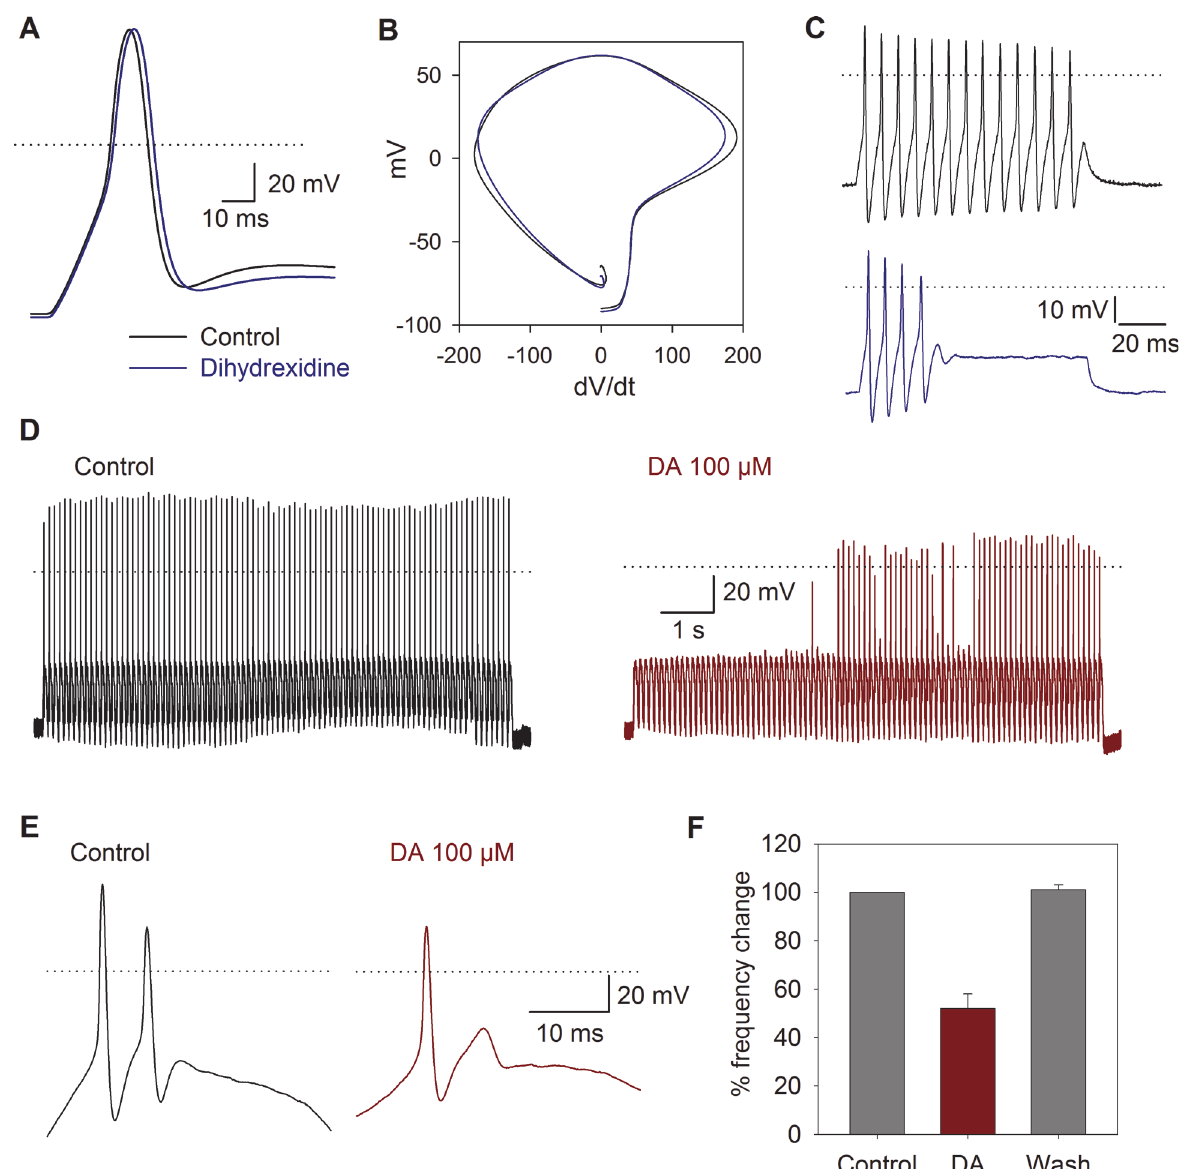
Fig 7. Current clamp response to sinusoidal stimulation and DA receptor activation. A) The use of 100 nM dihydrexidine (blue traces) shifted the maximum repolarization rate and increased the action potential duration. B) Phase plane plot of action potentials under control conditions and after dihydrexidine application. C) Action potentials produced by a current pulse injection of 150 pA were reduced from 13 under control conditions to 4 after dihydrexidine (100 nM). D) Typical response to sinusoidal current injection (10 Hz, 150 pA). Before the stimuli, the cells were held at − 80 mV. E) In a cell discharging in a 2:1 phase lock to sinusoidal stimuli, the use of DA reduced action potential discharges per cycle to a phase lock of 1:1 F) Bar graph showing the percent change in the number of action potentials in the control, after 100 μ M DA application and after washout of the